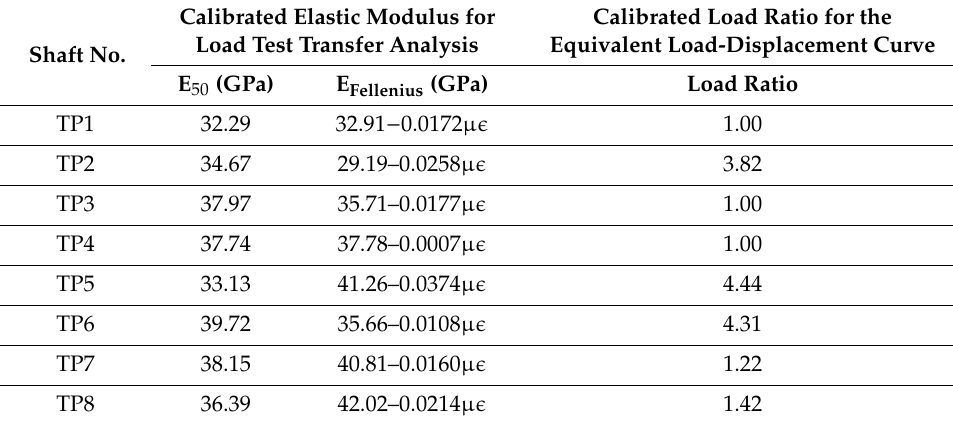
Figure 6. Estimation of the top-down load distribution from the bi-directional load test (TP 2). Table 3. Summary of calibrated elastic modulus and load ratio. Table 3. Summary of calibrated elastic modulus and load ratio.